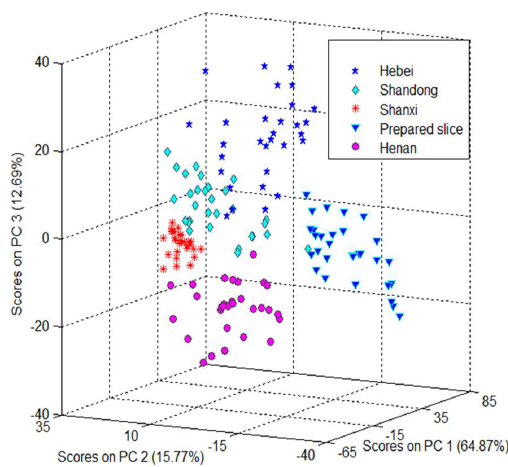
Figure 2. Score cluster plot of the top three principal components (PCs) of Trichosanthis Fructus for the data set.